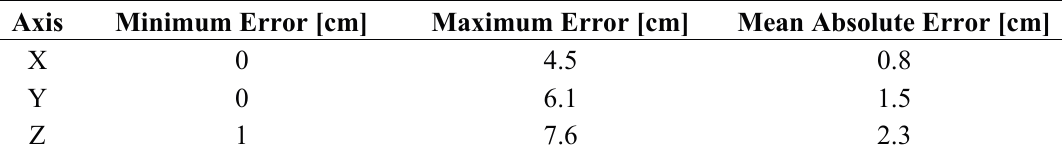
Table 3. Position errors from the TOF registered